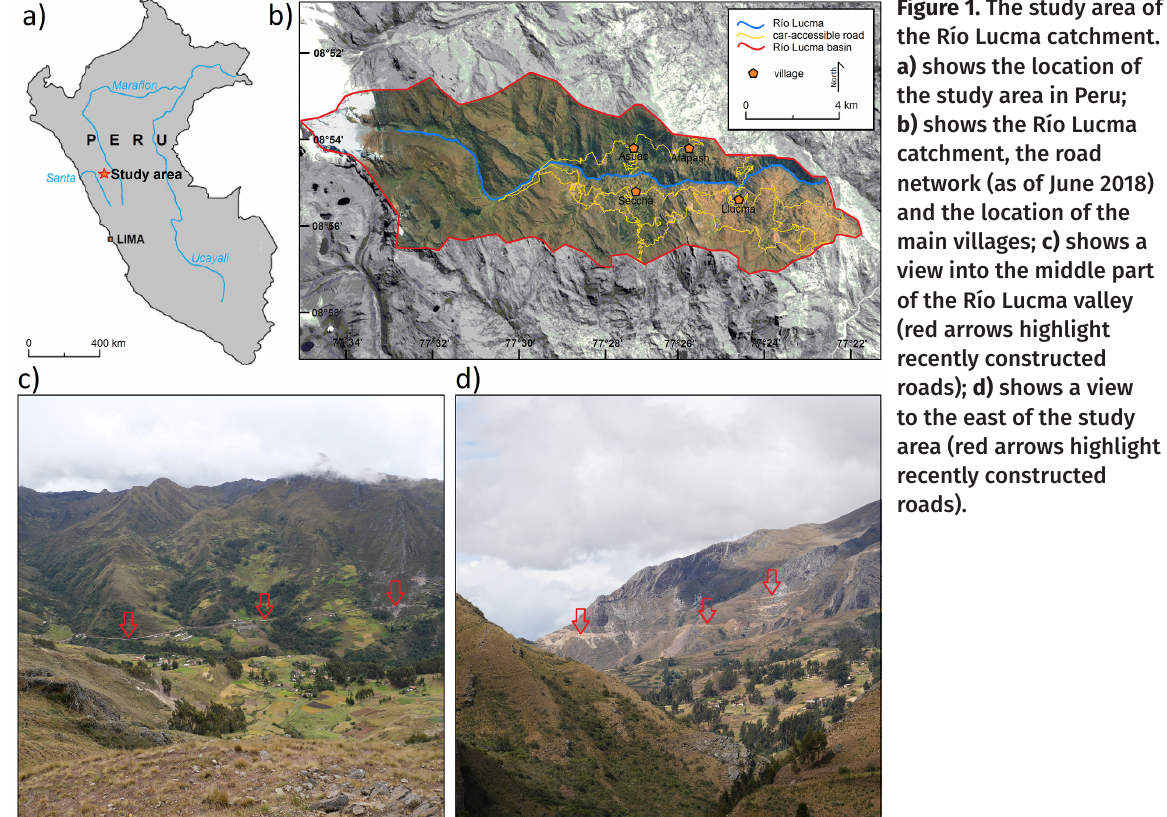
Figure 1. The study area of the Río Lucma catchment. a) shows the location of the study area in Peru; b) shows the Río Lucma catchment, the road network (as of June 2018) and the location of the main villages; c) shows a view into the middle part of the Río Lucma valley (red arrows highlight recently constructed roads); d) shows a view to the east of the study area (red arrows highlight recently constructed